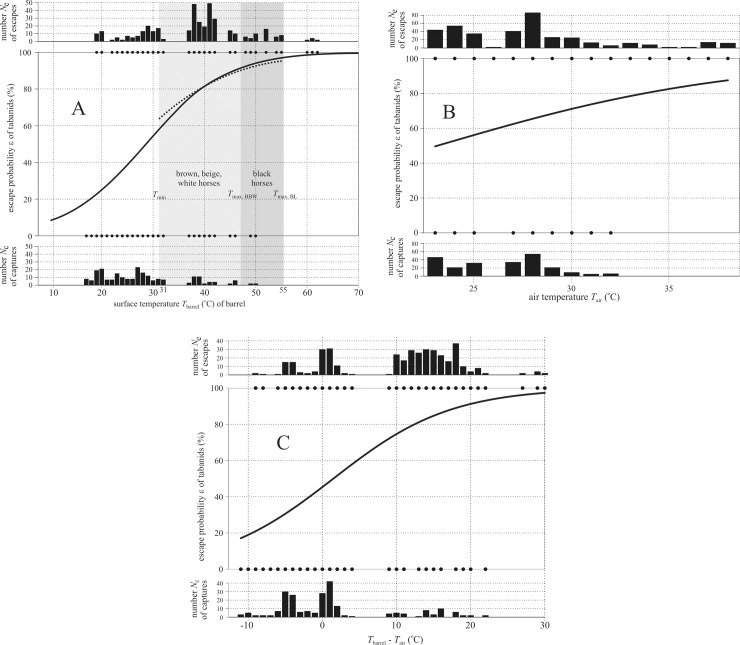
Results of logistic regressions.(A) Top: Number Ne of escaped horseflies versus the barrel surface temperature Tbarrel. Middle: Escape probability ε of horseflies, where the logistic curve is fitted to the dots showing the surface temperatures at which tabanids were escaped (ε = 100%) and captured (ε = 0%) within the 17°C ≤ Tbarrel ≤ 62°C interval. A dotted curve illustrates the logistic fit to the data within the 31°C ≤ Tbarrel ≤ 55°C interval. Bottom: Number Nc of captured horseflies versus Tbarrel. The vertical light and medium grey columns denote the interval Tmin = 31°C ≤ T ≤ Tmax,BBW = 47°C of the surface temperature of brown, beige and white (BBW) horses and the interval Tmin = 31°C ≤ T ≤ Tmax,BL = 55°C of black (BL) horses measured by thermography (Fig 2). (B) As A versus the air temperature Tair. (C) As A versus the difference Tbarrel—Tair.